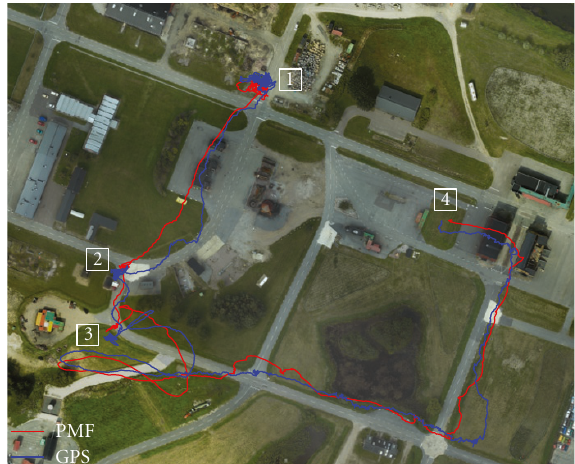
Figure 15: Real-time on-board position estimation results. Com- parison between the flight path computed with the PMF (red) and the GPS reference